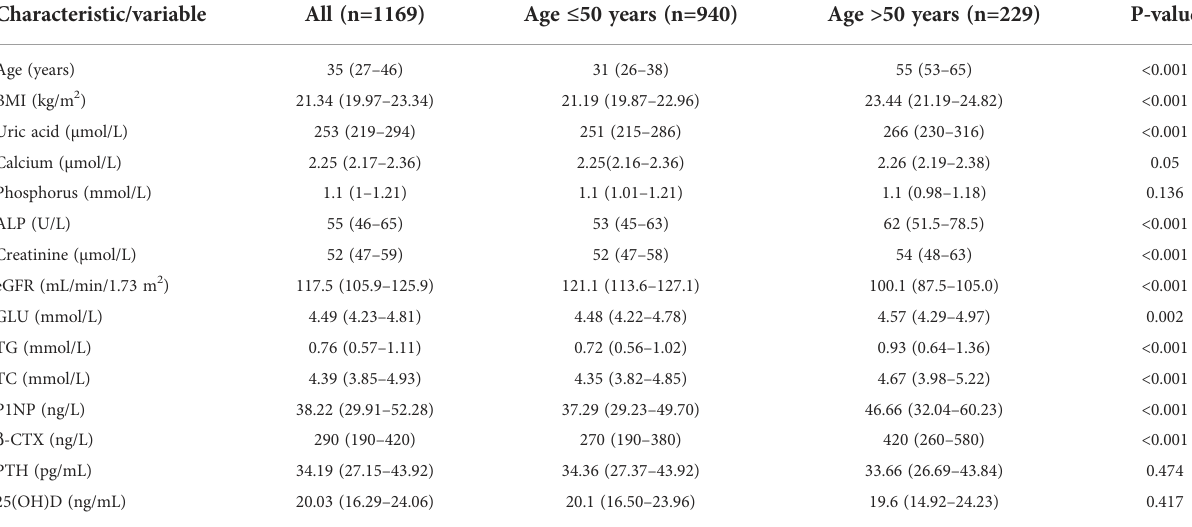
TABLE 2 Population characteristics and biochemical